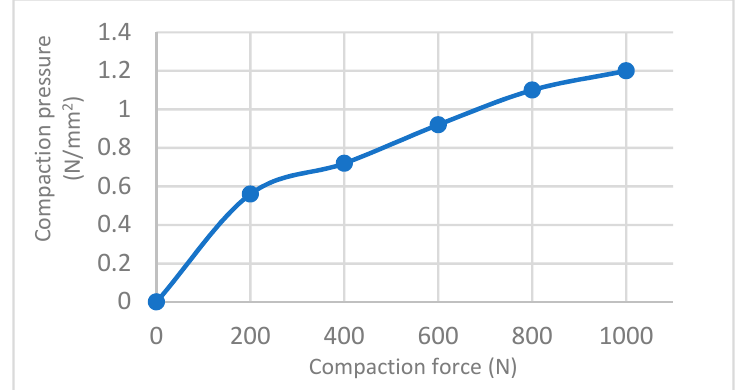
Figure 5. Compaction force vs. compaction pressure.